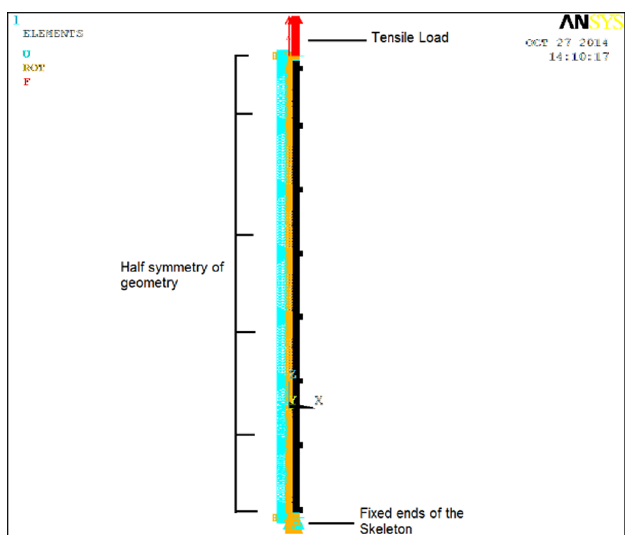
Fig. 4. Applied boundary conditions (3D plot).